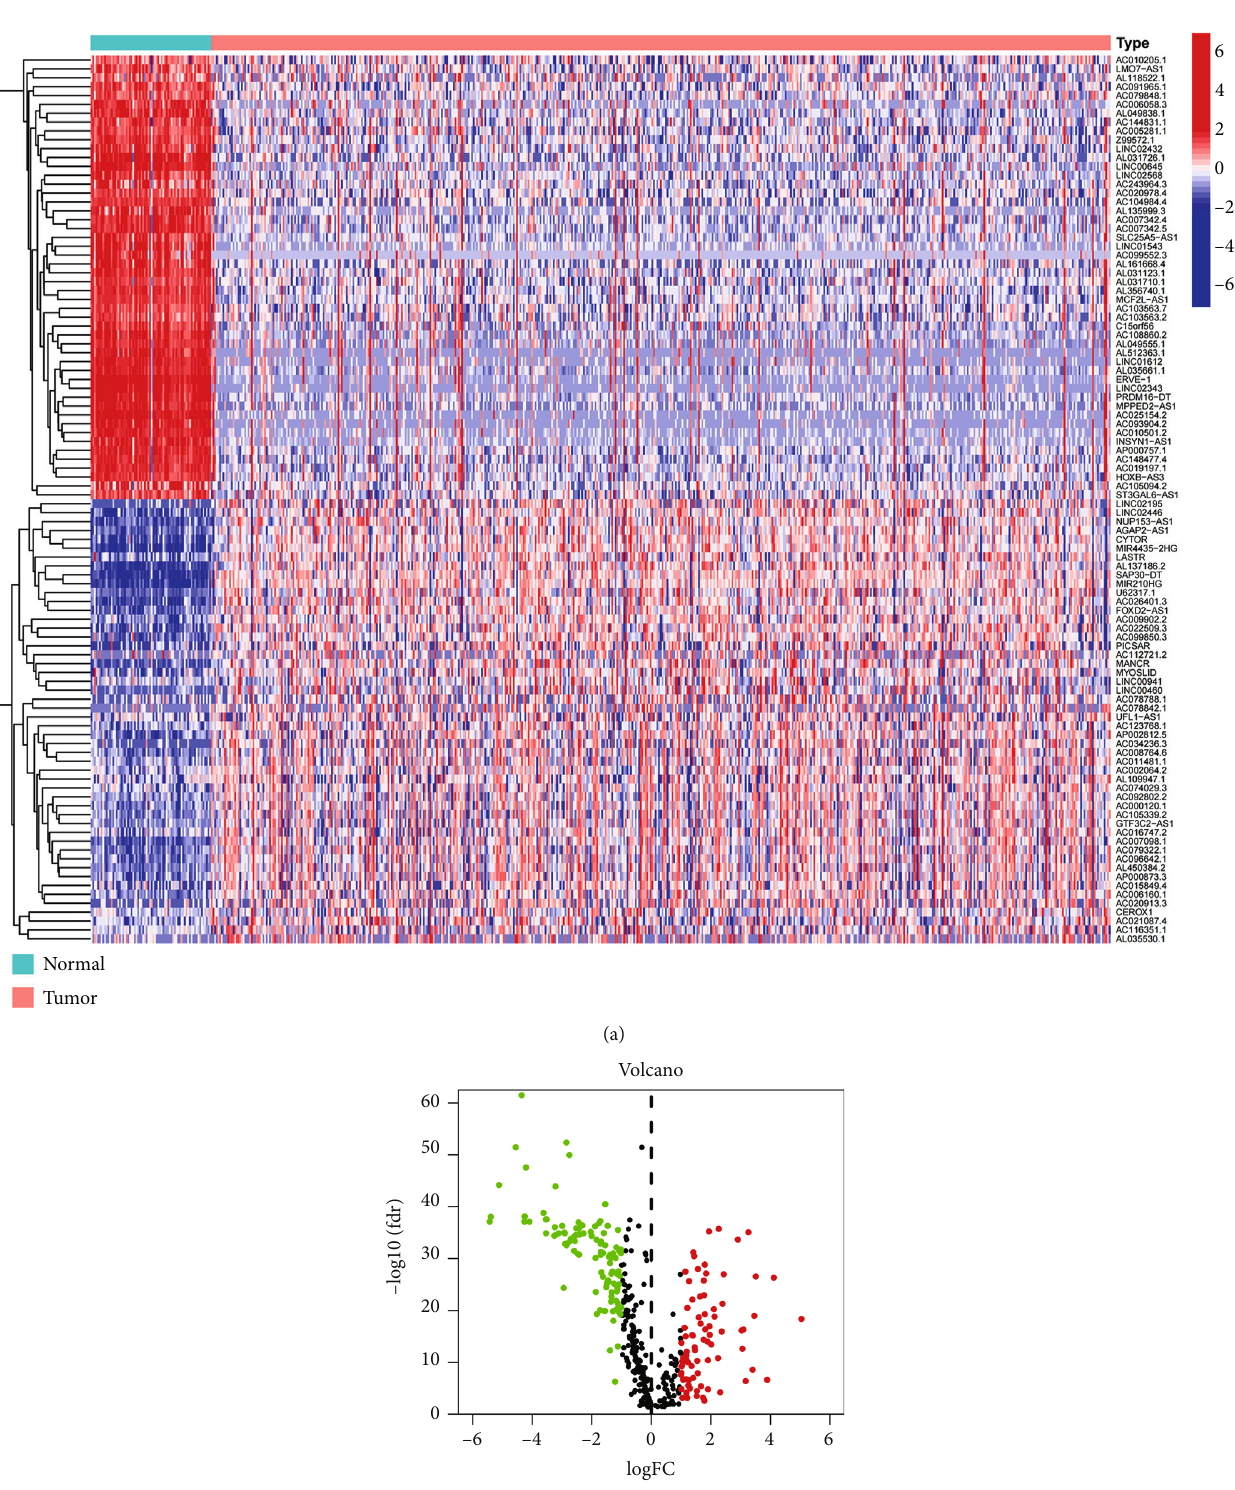
Figure 1: Identi fi cation of cuproptosis-related di ff erential long non-coding ribonucleic acids (lncRNAs) in clear cell renal cell carcinoma. (a) Heatmap of 50 most signi fi cantly regulated cuproptosis-related lncRNAs between tumor and paracancer samples, respectively. (b) A volcano map of di ff erential cuproptosis-related